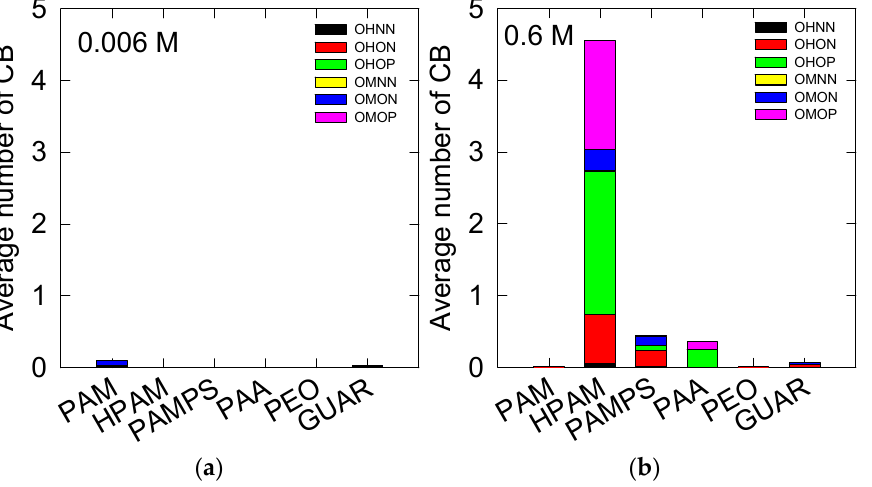
Figure 4. The time average of the HB between the polymers and the kaolinite surface (010). At salt concentrations of ( a ) 0.006 M and ( b ) 0.6 M of NaCl. See Figure 3 for legends.